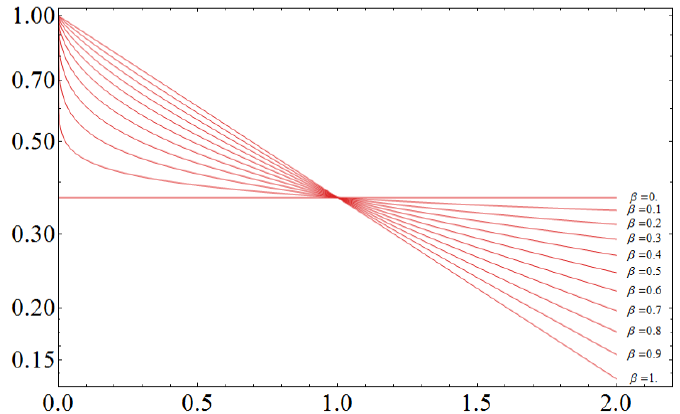
Figure 3. The stretched exponential on a log plot of novelty versus time for varying β